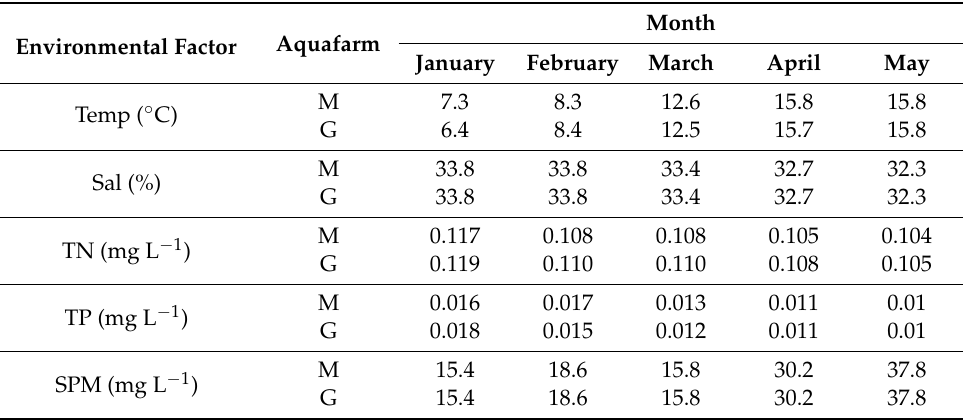
Table 1. Measurements of seawater temperature (Temp), salinity (Sal), total nitrogen (TN), total phosphorus (TP), and suspended particulate matter (SPM) at Myeongcheon (M) and Gyedo (G) aquafarms between January and May 2003.